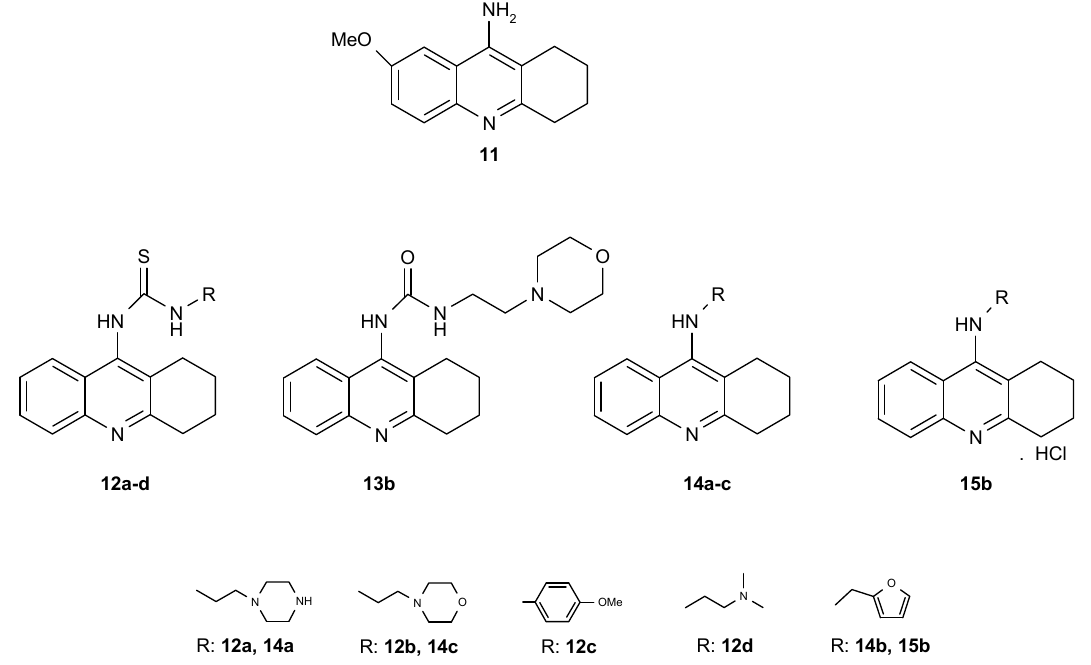
Figure 5. 7-MEOTA 11 and novel 9-substituted tacrine congeners 12–15 .